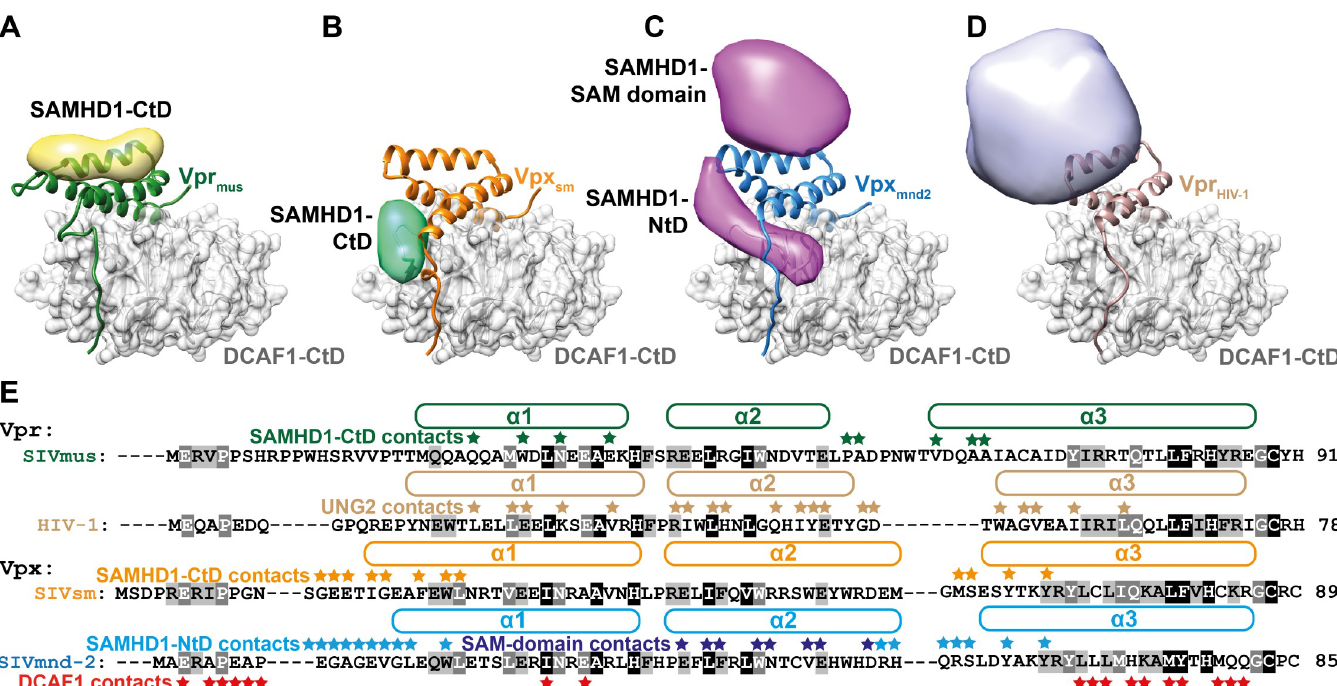
Fig 6. Variability of neo -substrate recognition in Vpx/Vpr proteins. Comparison of neo -substrate recognition modes of Vpr mus ( A ), Vpx sm ( B ), Vpx mnd2 ( C ) and Vpr HIV-1 ( D ). DCAF1-CtD is shown as grey cartoon and semi-transparent surface, Vpr mus − green, Vpx sm − orange, Vpx mnd2 –blue and Vpr HIV-1 – light brown are shown as cartoon. Models of the recruited ubiquitylation substrates are shown as strongly filtered, semi-transparent calculated electron density maps with the following colouring scheme: SAMHD1-CtD bound to Vpr mus − yellow, SAMHD1-CtD (bound to Vpx sm , PDB 4cc9) [50]–mint green, SAMHD1-NtD (Vpx mnd2 , PDB 5aja) [51]– magenta, UNG2 (Vpr HIV-1 , PDB 5jk7) [54]–light violet. ( E ) Multiple sequence alignment of Vpr and Vpx proteins from A - D . Helices are indicated by the boxes above the amino acid sequences. Residues involved in neo -substrate recognition are indicated by asterisks above the amino acid sequences. Residues involved in DCAF1-binding in all Vpr and Vpx proteins are indicated by red asterisks below the Vpr mnd-2 amino acid sequence. Residues shaded grey or black are at least 60% or 90% type-conserved in all Vpx and Vpr proteins, respectively.